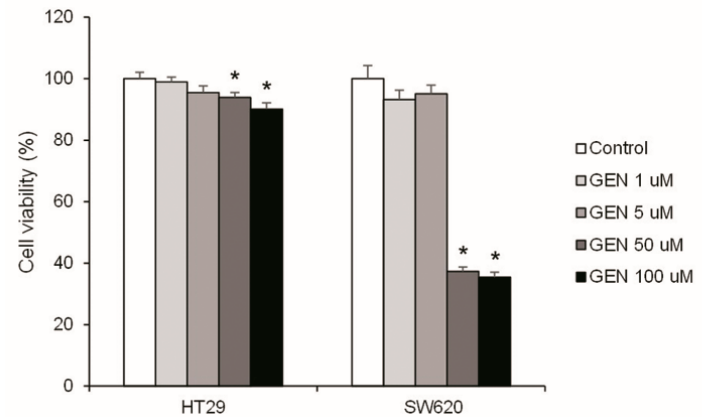
Figure 1. Effects of different concentrations of genistein on cell viability in HT29 and SW620 cells, determined with Hoechst 33342 assay. The value of control cells (DMSO-treated cells) was set at 100%. The coordinate values represent cell viability (%) and the measurements were made with genistein 1, 5, 50, and 100 µ M or 0.1% DMSO (control cells) treatment for 48 h. GEN, genistein. * Significant difference between control cells and genistein-treated cells (Student’s t -test; p < 0.05, n = 6).